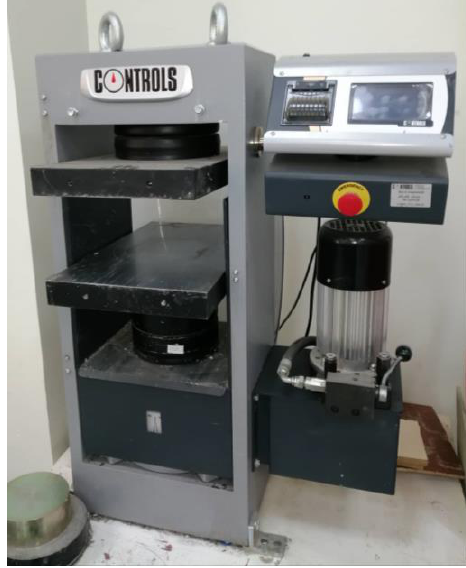
Fig. 4. Compression